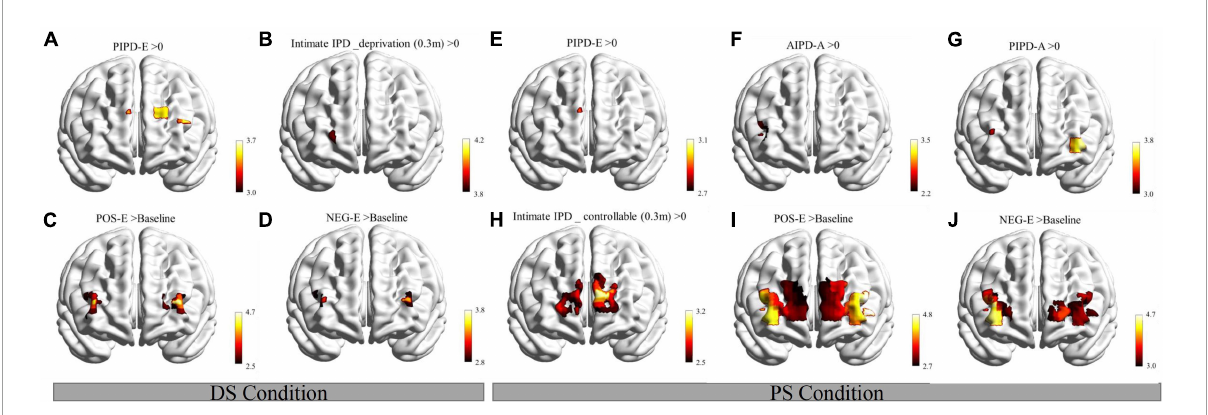
FIGURE5 Activation maps in the three IPD stages of the DS and PS conditions. (A) Activation maps in the IPD-Inclusion stage of the DS condition. (B) Activation maps in the IPD-control stage (deprivation process) of the DS condition. (C,D) Activation in the IPD-Affection stage of the DS condition. (E–G) Activation maps in the IPD-inclusion stage of the PS condition. (H) Activation maps in the IPD-control stage (controllable process) of the PS condition. (I,J) Activation in the IPD-affection stage of the PS condition. DS, differing social status; PIPD-E, passive interpersonal distance during the evaluation period; AIPD-A, active interpersonal distance during the action period; PIPD-A, passive interpersonal distance during the action period; intimate IPD_deprivation (0.3 m), intimate IPD (0.3 m) during deprivation process; intimate IPD_controllable (0.3 m), intimate IPD (0.3 m) during controllable process; POS-E, IPD evaluation period after positive feedback; NEG-E, IPD evaluation period after negative feedback. The vertical color scale indicates the statistical significance of the T -values. > , compared to. Significance of all maps were set as FDR_ p ≤